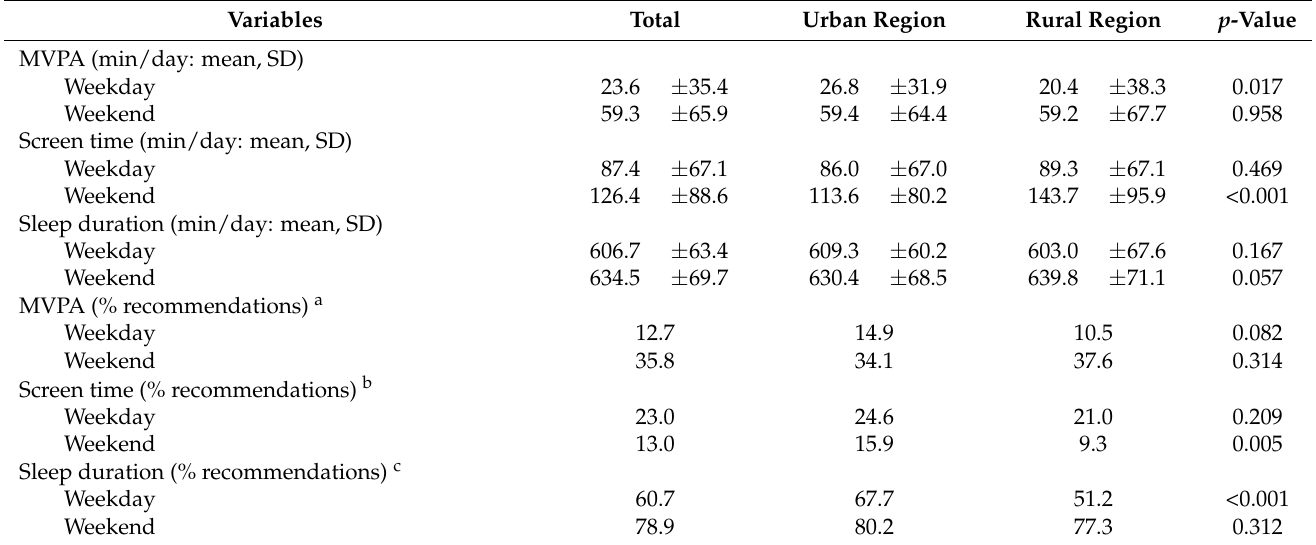
Table 3. Urban/rural differences in children’s MVPA, screen time, sleep duration, and compliance with